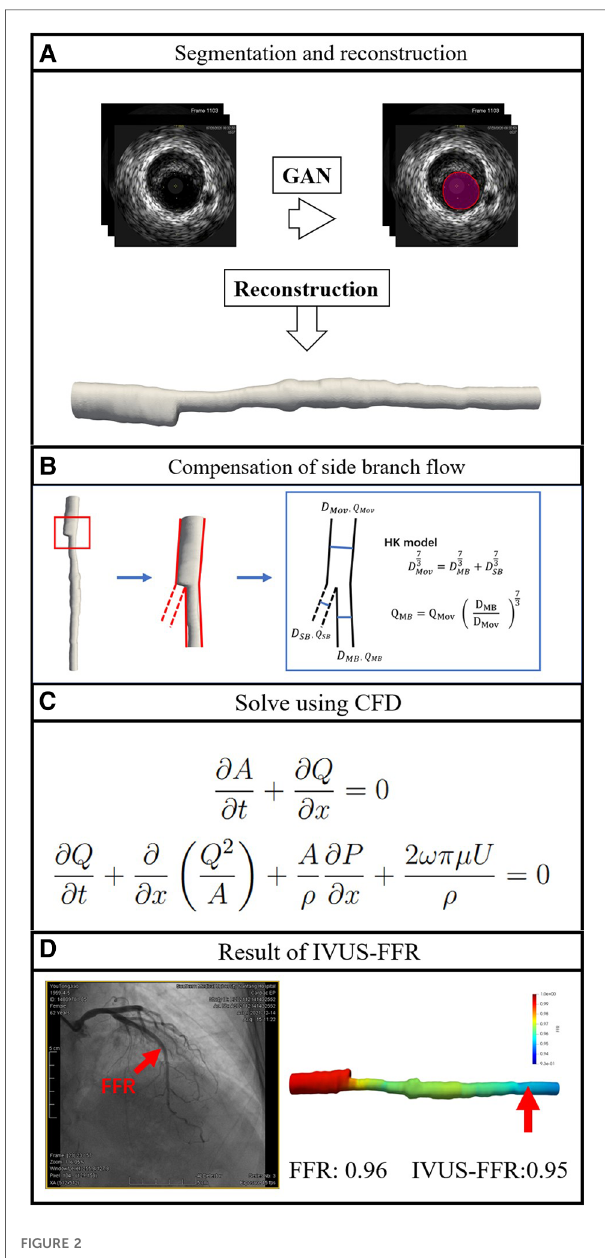
FIGURE 2 Work fl ow of IVUS-FFR analysis. The lumen borders in the IVUS images are automatically segmented and reconstructed into a single-tube 3D coronary artery model ( A ). Compensation of branch vessel fl ow was calculated by the HK model ( B ). Using computational fl uid dynamics to solve the Navier-Stokes equations that govern blood fl ow ( C ). IVUS-FFR was calculated and superimposed on the reconstructed 3D model ( D